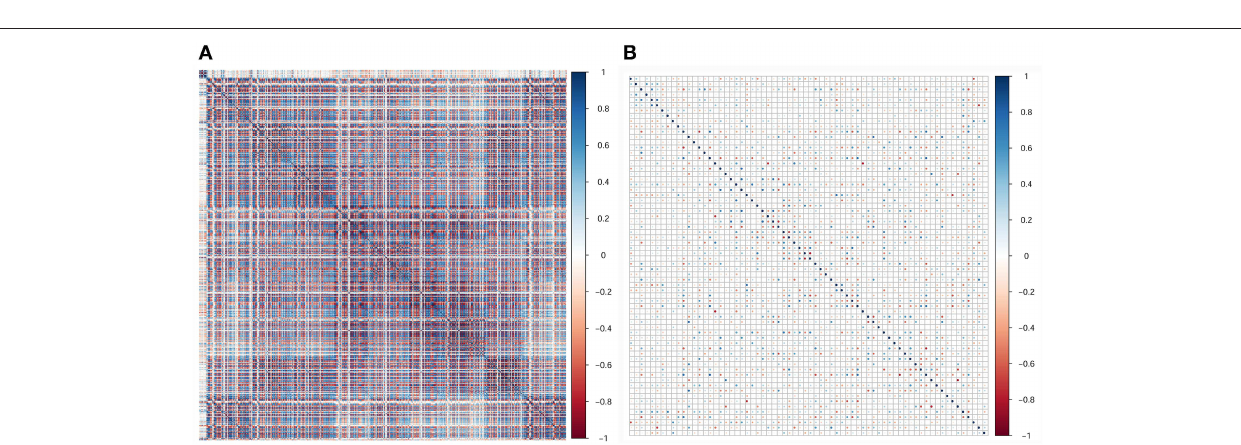
Frontiers in Oncology |